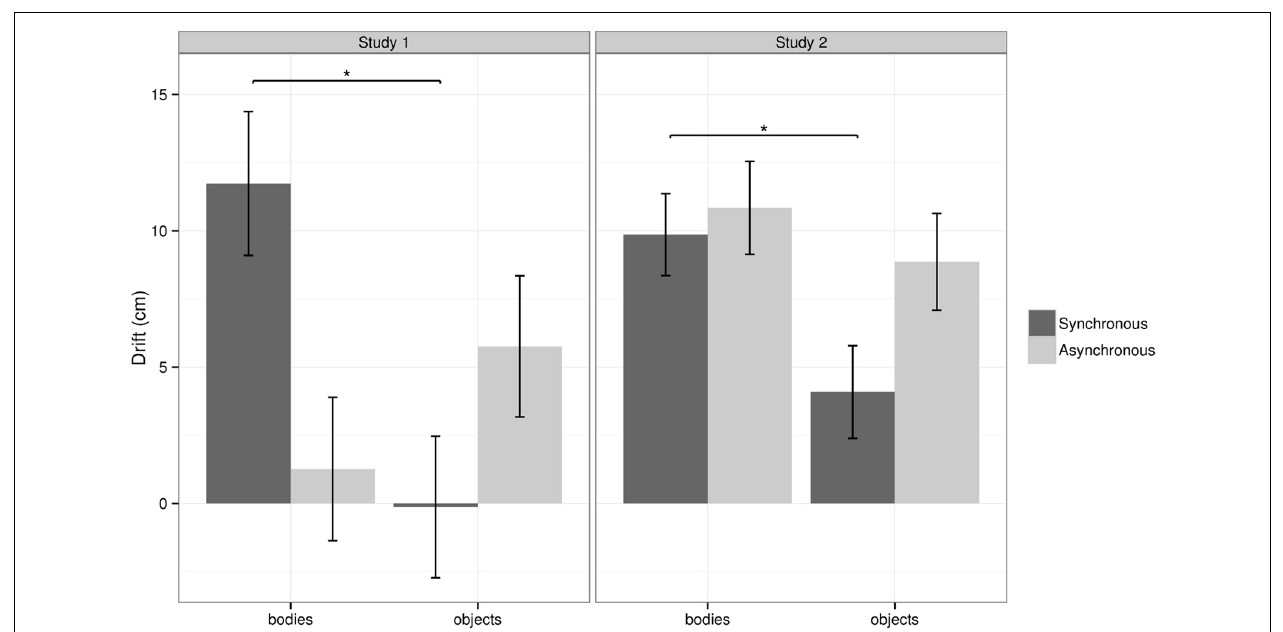
analysis showed a significant interaction between body and synchrony for study 1. The main effects and interaction effect were not significant for study 2, and the pairwise comparison was referred to in the